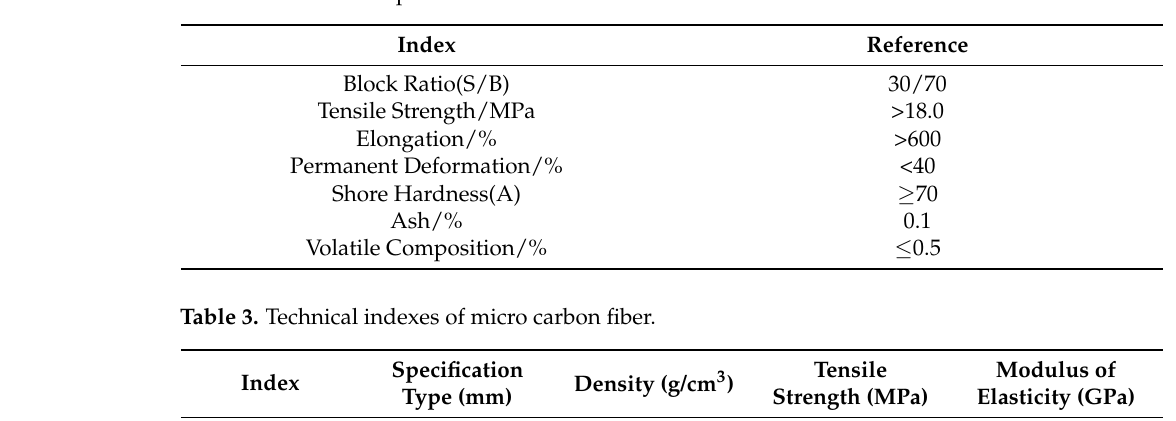
Table 2. SBS material performance index.